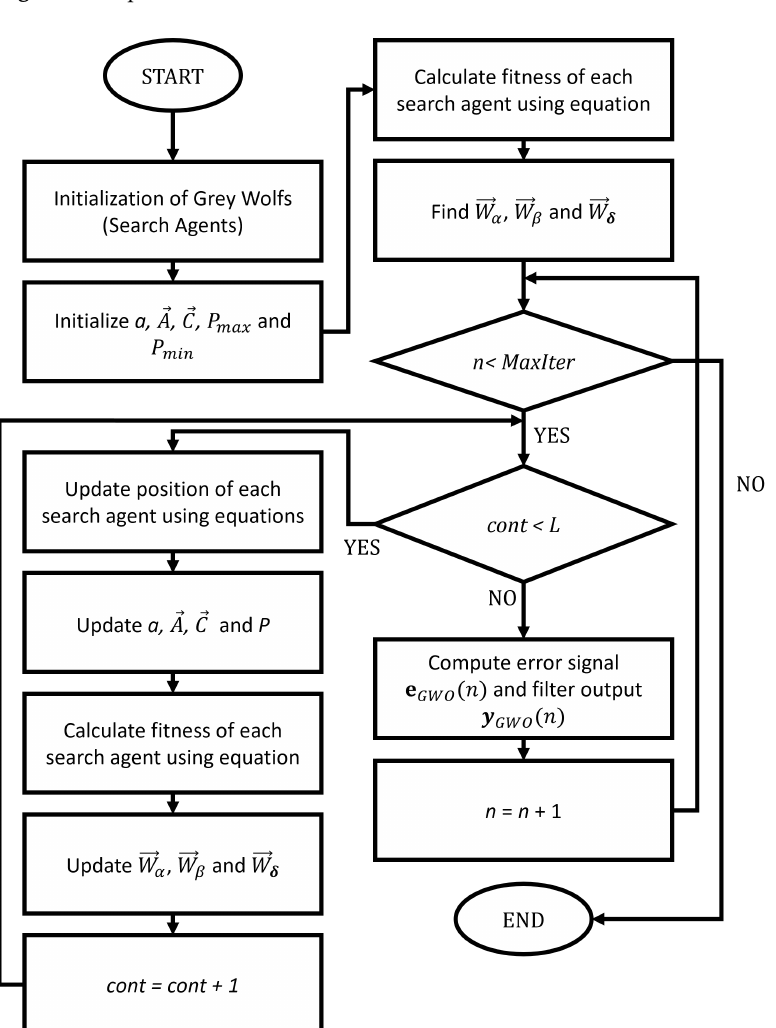
Figure 2. The flowchart of the block GWO